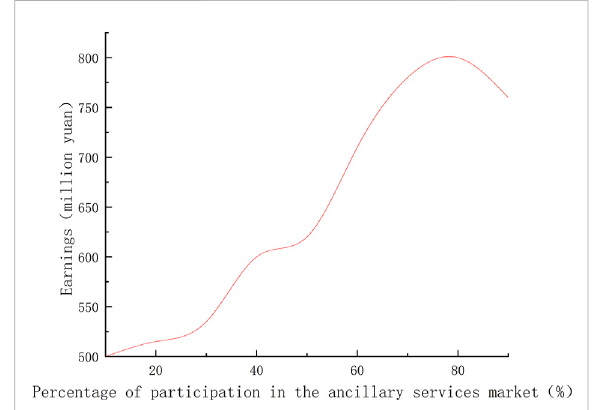
FIGURE 11 The pro fi t of PSPP when the price coef fi cient of the transferred power is 1.1.